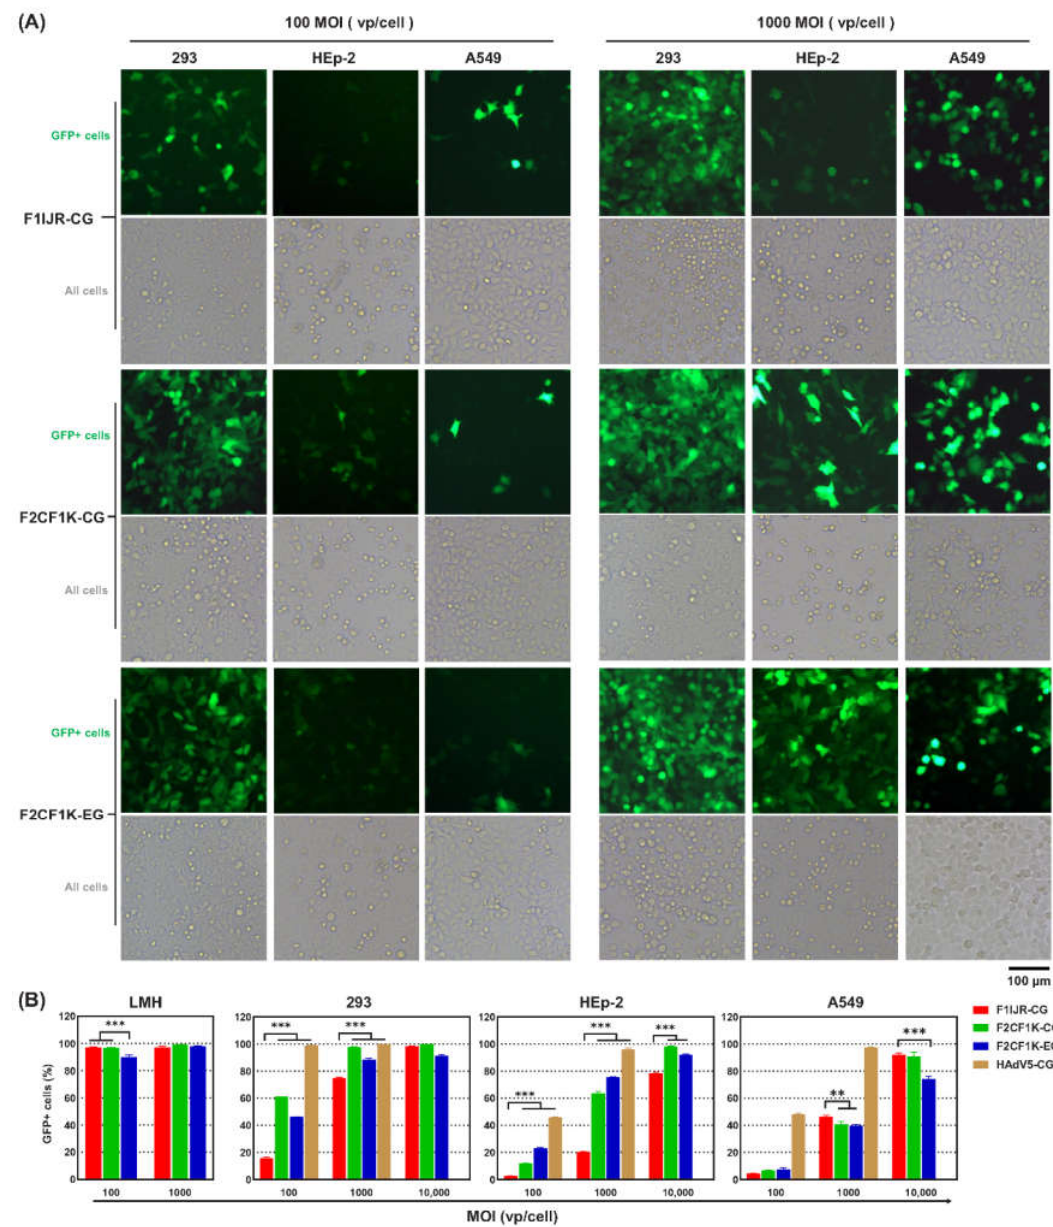
Figure 3. Transduction of human adherent cell lines with fiber‑modified FAdV‑4 vectors carrying GFP reporter gene. ( A ) Human 293, HEp‑2 and A549 cells were infected with FAdV4‑F2CF1K‑CG (F2CF1K‑CG) or FAdV4‑F2CF1K‑EG (F2CF1K‑EG) viruses at various MOIs for 4 h. GFP expression was observed under a fluorescence microscope at 48 h post‑infection. FAdV4‑F1IJR‑CG (F1IJR‑CG), a previously constructed FAdV‑4 carrying RGD4C‑modified fiber1, served as a control. F1IJR‑CG had an improved capability to transduce human cells when compared with original FAdV‑4 vector [21]. ( B ) Quantitative analysis of GFP+ cells by flow cytometry. Cells were detached by trypsin treatment, dispersed into single cells and fixed in 1.5% paraformaldehyde at 2 days post‑virus infection, and the expression of GFP was determined by flow cytometry. In some tests, recombinant HAdV‑5 carrying CMV promoter controlled GFP expression cassette (HAdV5‑CG) was used as the positive control. experiment out of the three performed. ** p < 0.01, *** p <